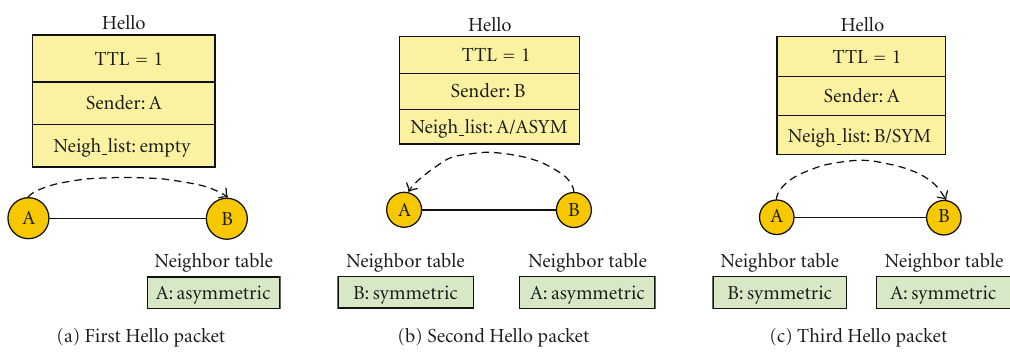
Figure 1: Example of Hello messages exchange to identify bidirectional